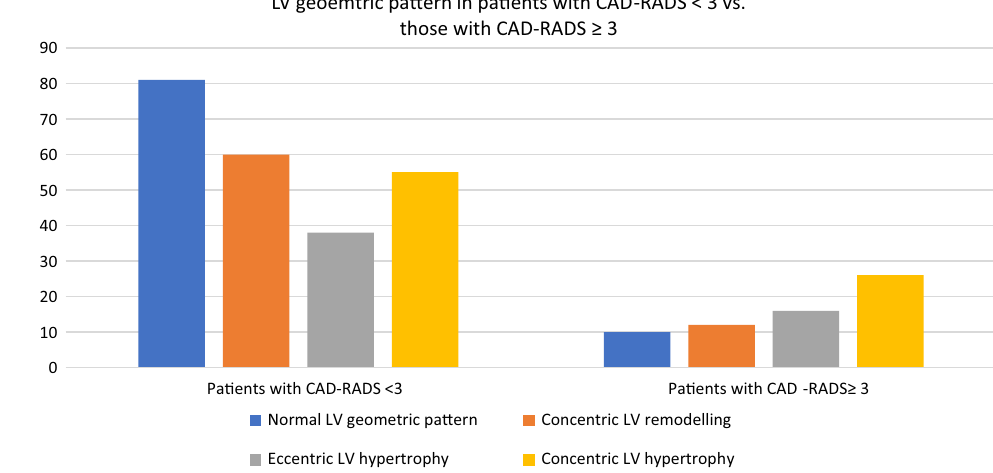
Fig. 4 Comparison of the LV geometric pattern between patients with CAD-RADS < 3 vs. those with CAD-RADS